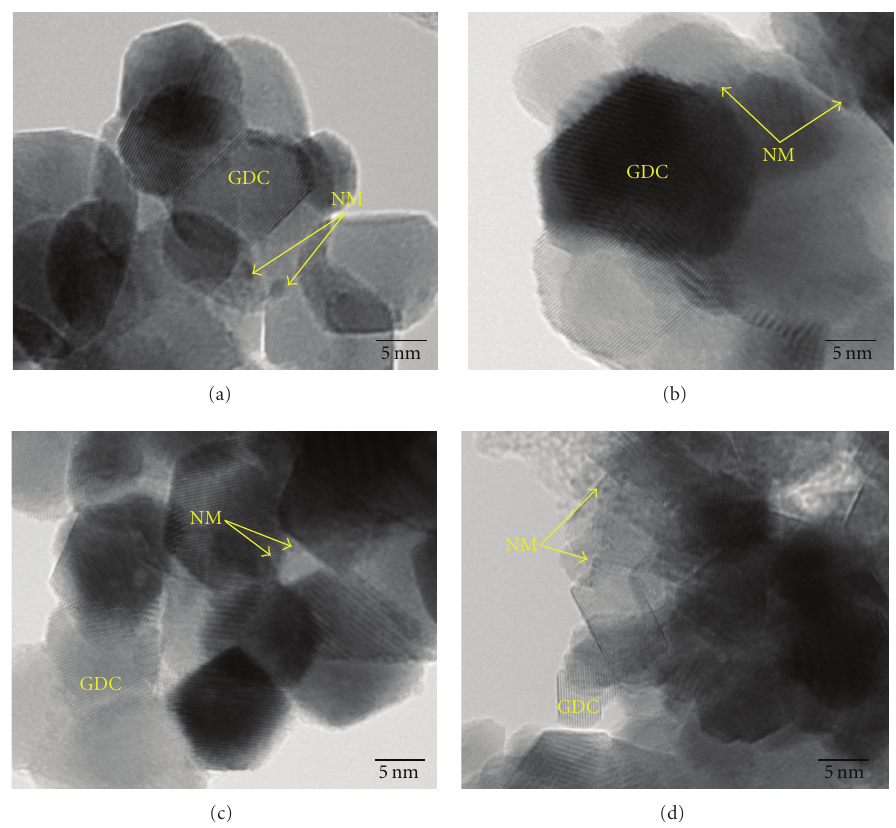
Figure 9: TEM image of the postreformed catalysts in the tri-metal series: (a) RPR333, (b) RPR322, (c) RPR232, and (d) RPR223.